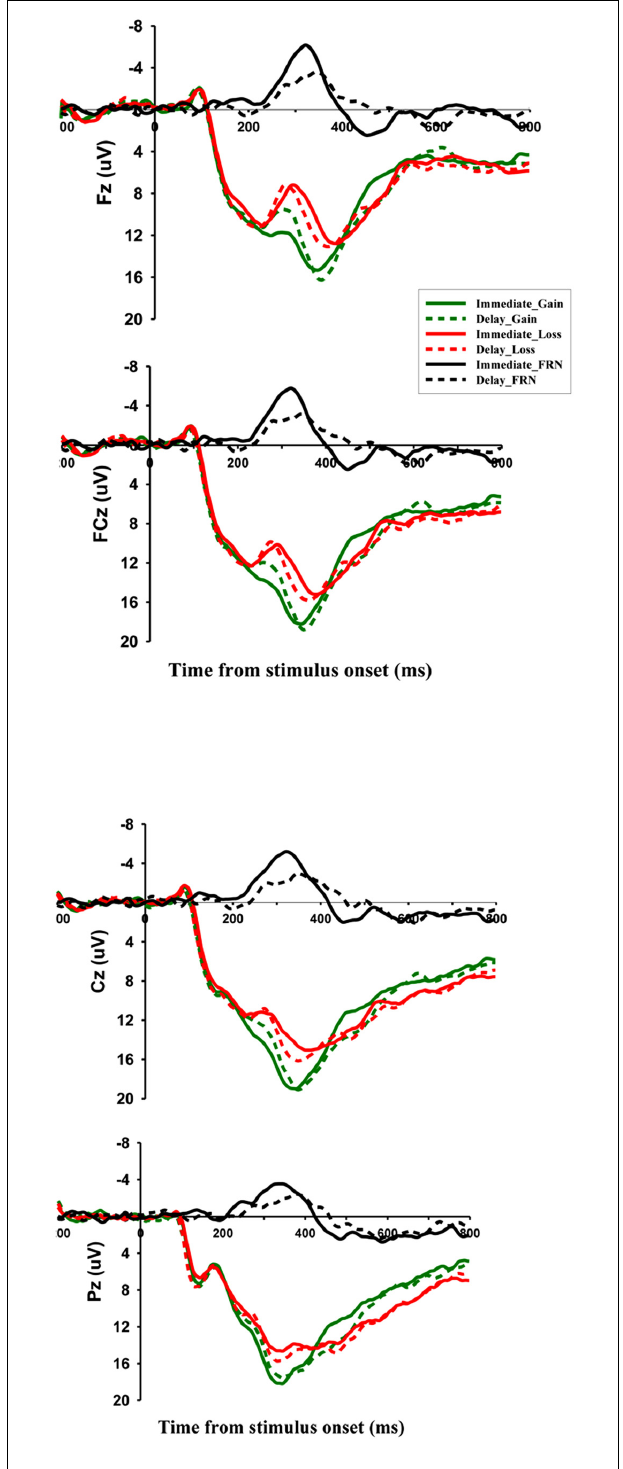
FIGURE 2 | Grand-averaged ERPs and difference waves for immediate rewards and delayed rewards at Fz, FCz, Cz, and Pz. Difference waves were created by subtracting the feedback-evoked ERP associated with negative feedback from the ERP associated with positive feedback.The solid black line represents difference waves for immediate rewards, while the dotted black line represents difference waves for delayed